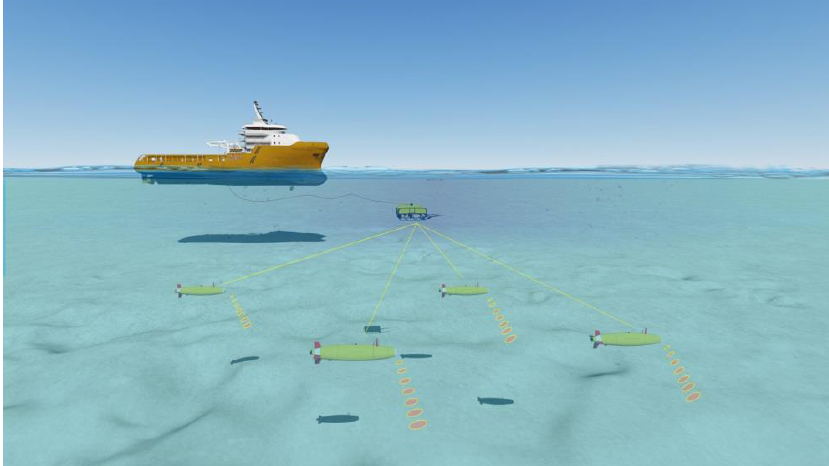
Figure 16. Link all the actors for landmark localization and seabed mapping in the SWARMs project.